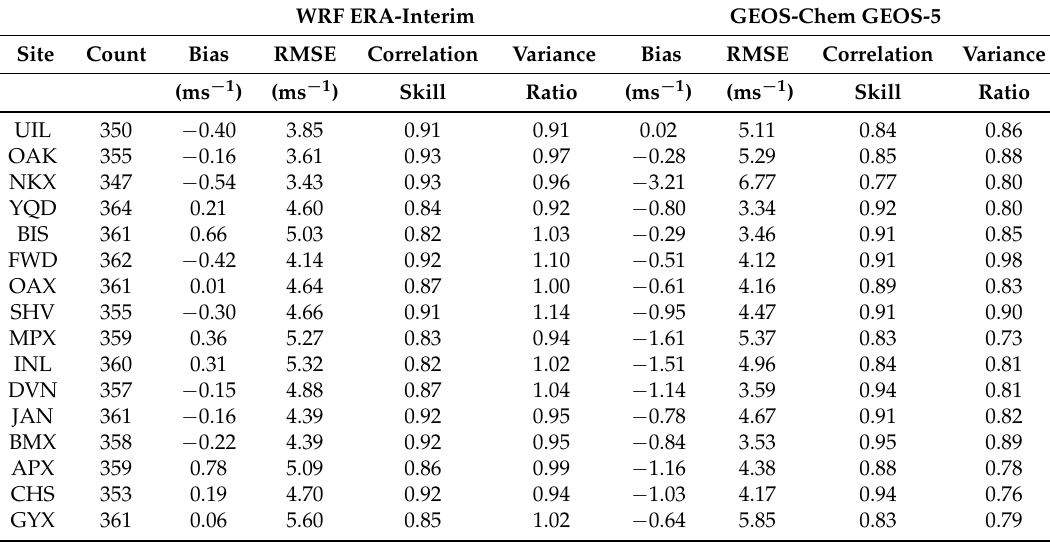
Table A2. Model comparison to rawinsonde wind speed at mandatory reporting level 500 hPa, 00 UTC in